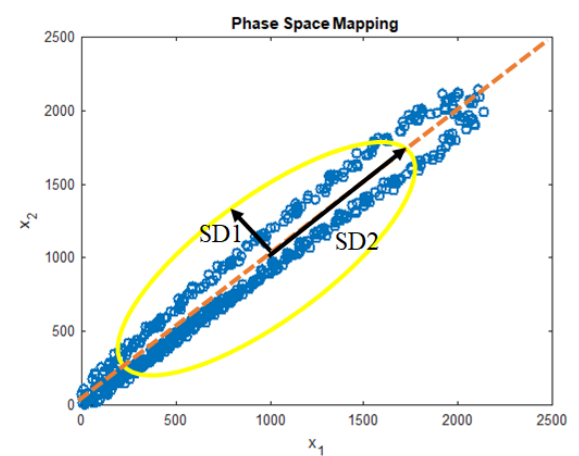
Fig. 3. Phase space mapping.